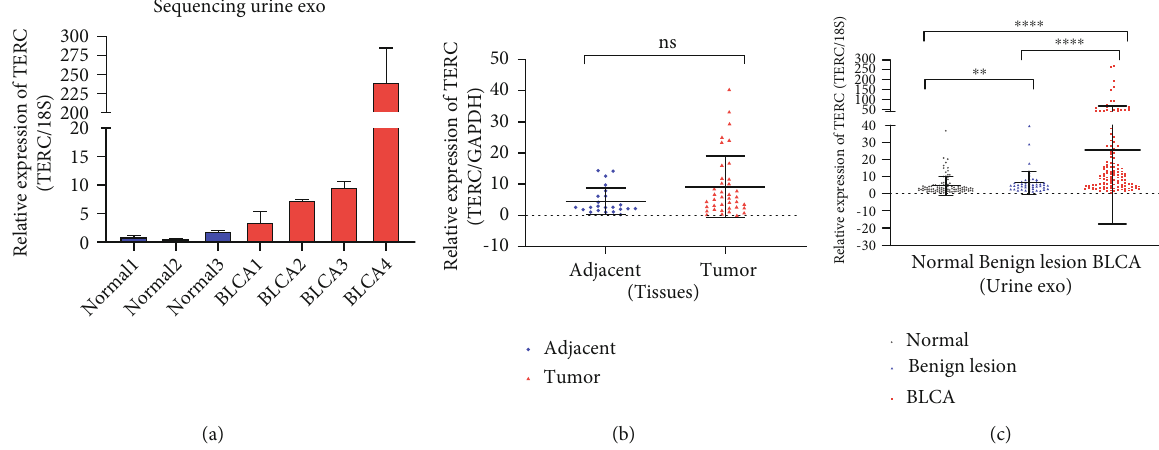
Figure 3: Relative telomerase RNA component (TERC) expression levels in bladder urothelial carcinoma (BLCA) patients. (a) TERC expression levels in urinary exosome samples from the three healthy controls and four BLCA patients used for RNA-sequencing are shown as mean ± SD . (b, c) Real-time quantitative PCR detection of TERC in di ff erent sample types including urine exosomes and tissues (ns: P > 0 : 05 , ∗∗ P < 0 : 01 , ∗∗∗∗ P < 0 : 0001 ). Relative expression levels in tissues were normalized to GAPDH , while 18S was used as the internal reference gene in exosomes. Groups were compared with the nonparametric Mann – Whitney U test.